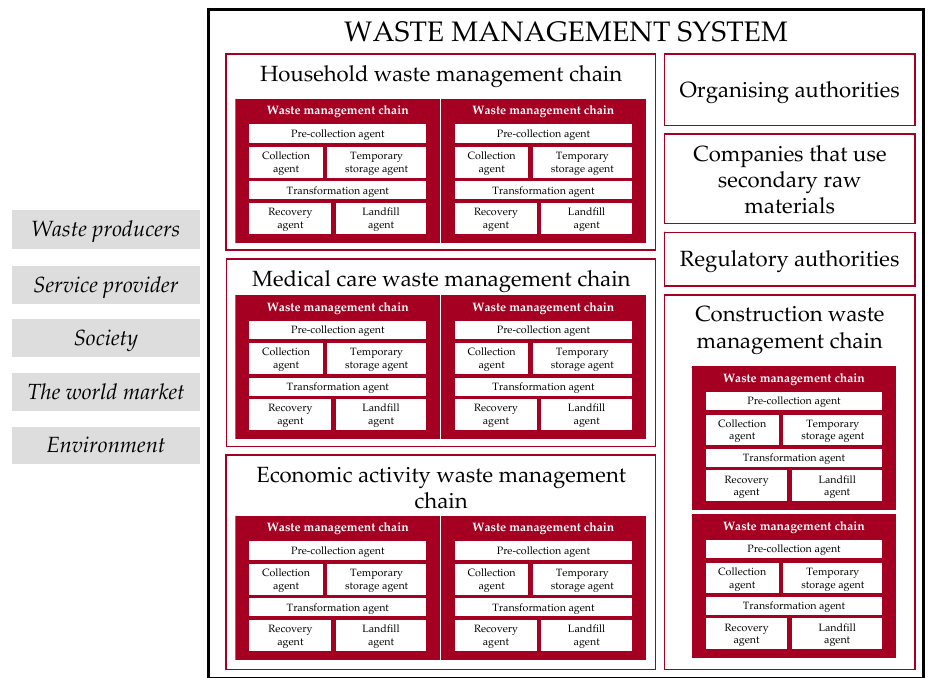
Fig. 1. Organisation of a waste management Figure 1 : Organization of waste management system 14